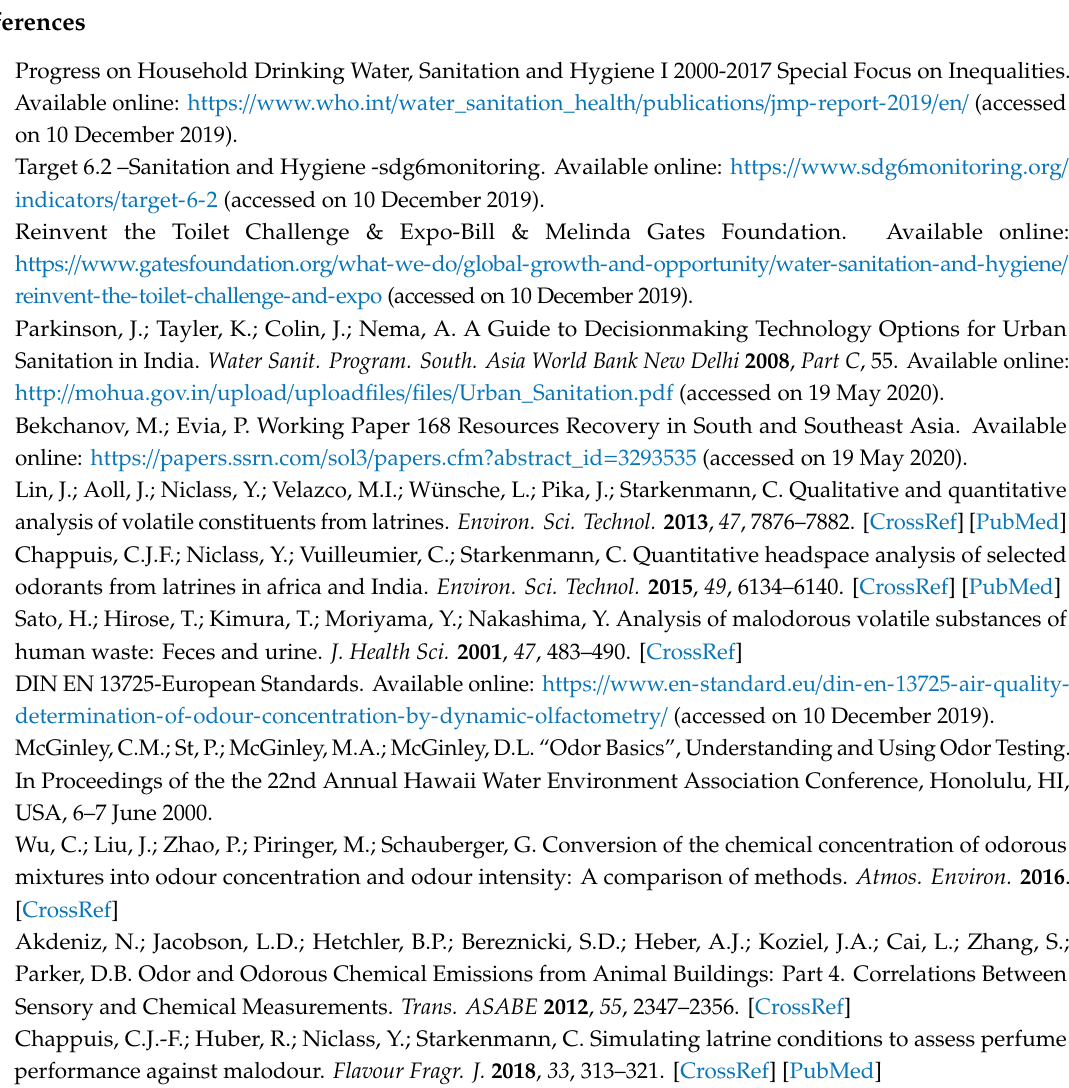
Table S1. Response time of the system to reach 63% (T63) and 90% (T90) of the steady-state value. Table S2. R 2 values for the dose-response of sensors to the three fecal odorants. Figure S1. Dose-response to three fecal malodor specimens by the sensors not shown in the main